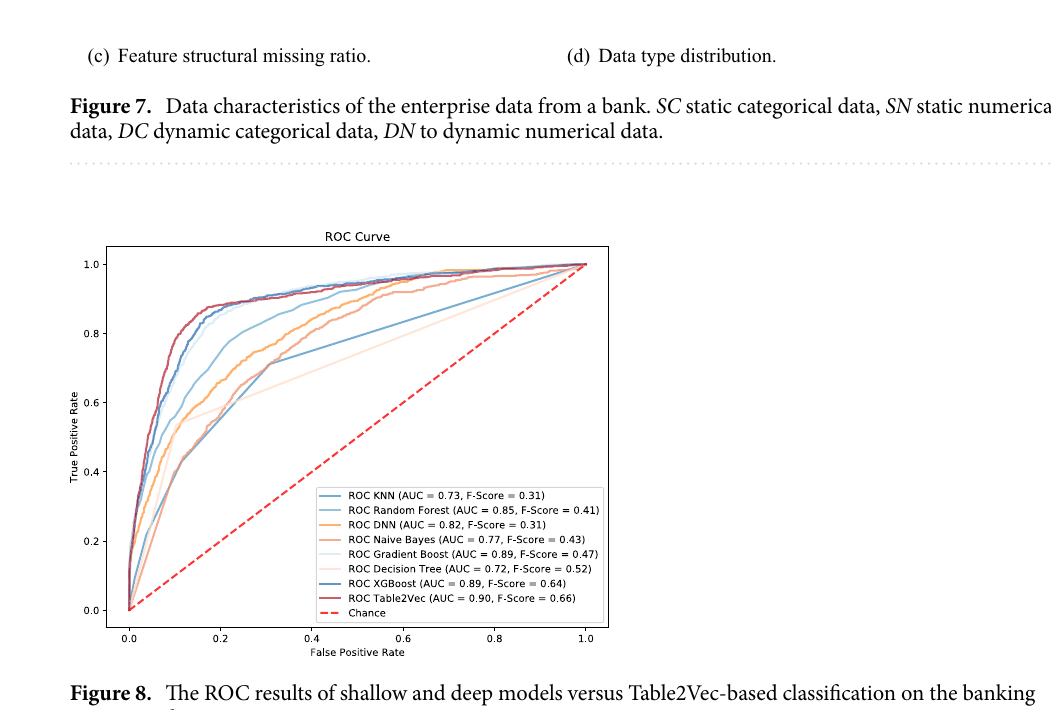
Figure 8. The ROC results of shallow and deep models versus Table2Vec-based classification on the banking enterprise